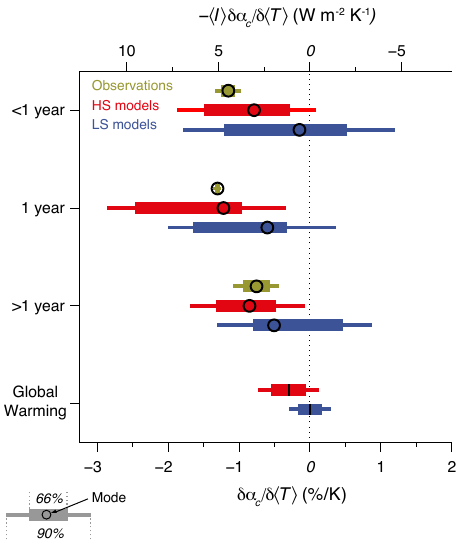
Figure 11. Observed and simulated covariance of TLC reflec- tion with surface temperature. Twenty-nine CMIP5 models are used. Intra-annual (<1 year), seasonal (1 year), and interannual (>1 year) frequency bands are distinguished. The regression co- efficients δα c /δ (cid:104) T (cid:105) are shown with their modes (most likely val- ues) and 66 and 90% confidence intervals, for observations, 14 HS climate models, and 15 LS GCMs. Angle brackets (cid:104)(cid:105) denote the mean over the TLC regions. For the models, δα c /δ (cid:104) T (cid:105) is also shown for global-warming simulations, calculated from the cloud reflec- tion and temperature differences in the TLC regions between years 130–149 and years 2–11 after an abrupt quadrupling of carbon diox- ide concentrations. For the global-warming simulations, the corre- sponding approximate confidence intervals (0.95 σ and 1.65 σ) ob- tained from the standard deviation σ of δα c /δ (cid:104) T (cid:105) among the HS and LS models are shown, with the bar marking the multimodel median. The upper axis indicates −(cid:104) I (cid:105) δα c /δ (cid:104) T (cid:105) , which approxi- mates the variation of the shortwave cloud radiative effect ( S c ) with temperature, δ (cid:104) S c (cid:105) /δ (cid:104) T (cid:105) . (cid:104) I (cid:105) is the regional mean solar insolation. Reprinted from Brient and Schneider (2016), ©American Meteoro- logical Society. Used with permission.